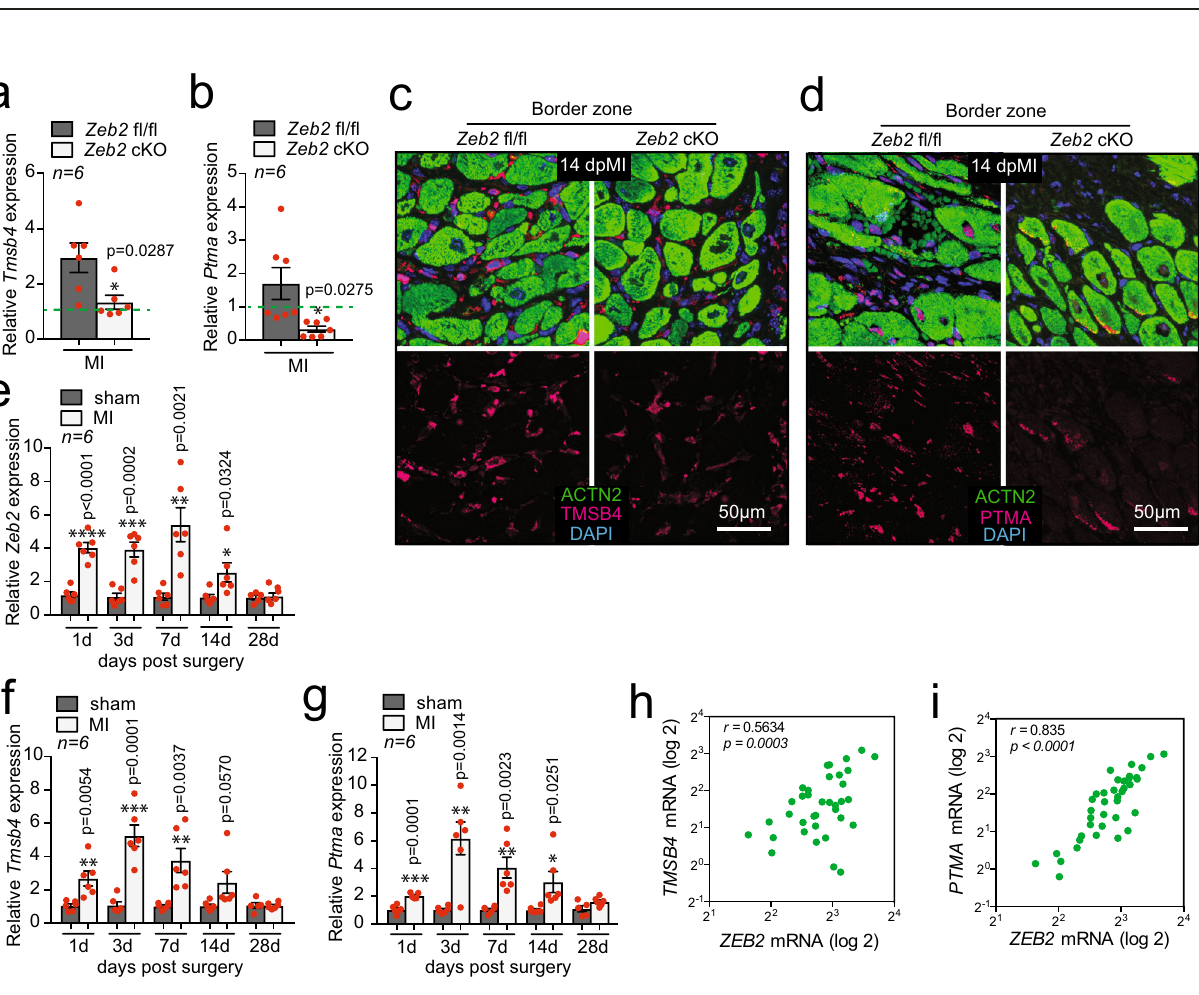
Fig. 3 Mass spectrometry to identify ZEB2 targets. a Experimental setup. b Fractionation strategy of conditioned medium for mass spectrometry purposes. c - d Representative images of scratch assay in HUVECs treated with the indicated conditioned media at 0 and 20 hours after treatment. e - f Quanti fi cation of wound closure from ( c - d ). g - h mRNA expression levels of Vegfr1, Vegfr2 , Fgf2, and Notch1 in HUVECs after treatment with conditioned medium. i Pie charts showing numbers of proteins identi fi ed by mass spectrometry in fraction 3-30 kDa. j ZEB2 overexpression in H10 cells and k ZEB2 inhibition in NRCMs. l - m Validation of mRNA expression of genes encoding for the 11 selected proteins identi fi ed by mass spectrometry in ( I ). Green dashed line indicates corresponding control. Data are represented as mean ± SEM, * p < 0.05, ** p < 0.01, each dot indicates a biological replicate, n is indicated in fi gures. Comparison of two groups was performed with the unpaired, two-tailed Student ’ s t -test compared to the control indicated as green dashed line ( g , h , l , m ). Source data are provided as a Source Data fi le.